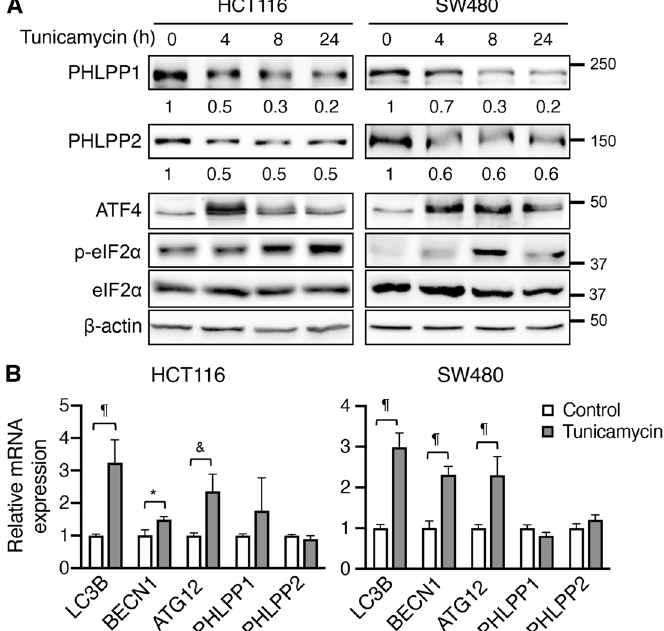
Fig. 1 Tunicamycin-induced ER stress induces PHLPP downregulation. a HCT116 and SW480 cells were treated with tunicamycin for the indicated time. Cell lysates were analyzed for the expression of PHLPP1, PHLPP2, ATF4 and eIF2 α and β -actin using Western blot. The phosphorylation status of eIF2 α was detected using the phospho-eIF2 α (p-eIF2 α ) antibody. The relative expression levels of PHLPP1 and PHLPP2 were obtained by normalizing to β -actin. b The relative expression of LC3B (gene name MAP1LC3B ), BECN1 (beclin1), ATG12 , PHLPP1 , and PHLPP2 mRNA was determined using RT-qPCR following the treatment with tunicamycin for 24 h in HCT116 and SW480 cells. Data represent the mean ± SD (¶ p < 0.0001, & p < 0.001 and * p <